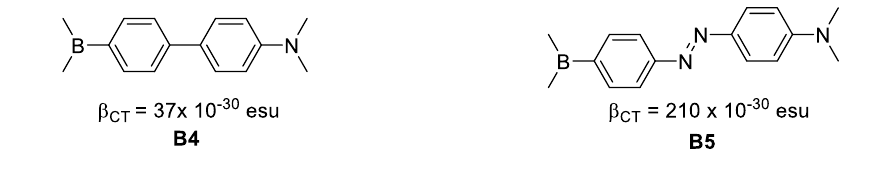
Figure 10. Second order hyperpolarizabilities for B4 and B5 .